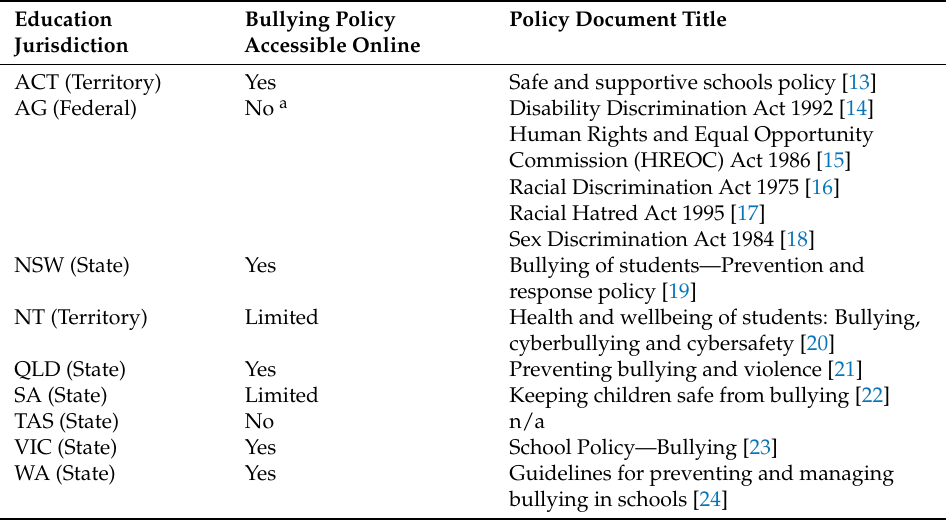
Table 1. Australian educational bullying policy and associated